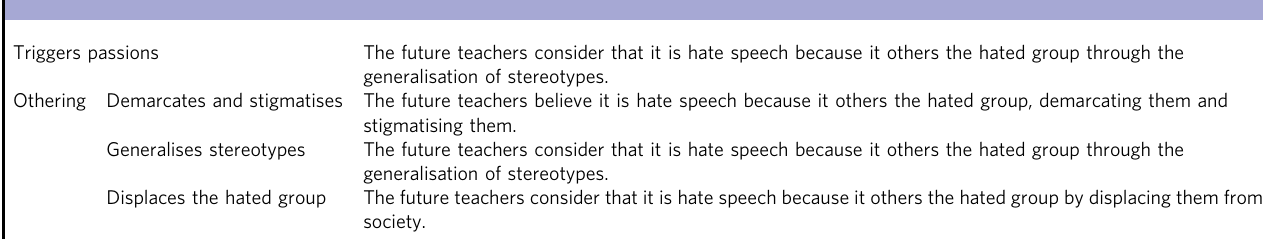
Table 2 Categories of analysis for future teachers ’ responses in activity 2 based on the works of Mouffe (2000, 2005) and Parekh